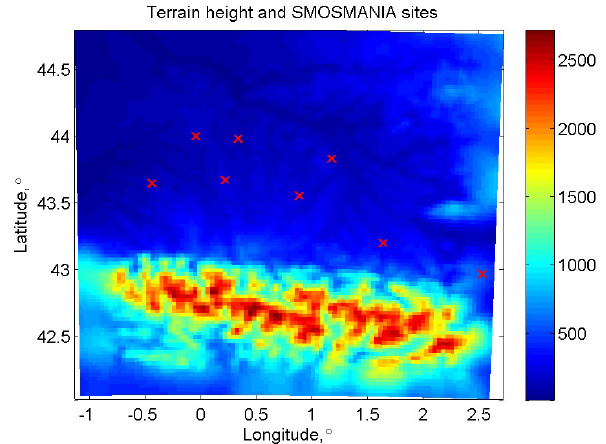
Figure 5. Terrain height on inner WRF domain with the eight SMOSMANIA sites used in Fig. 6 plotted as red X marks. Color bar shows the terrain height scale in ma.s.l.